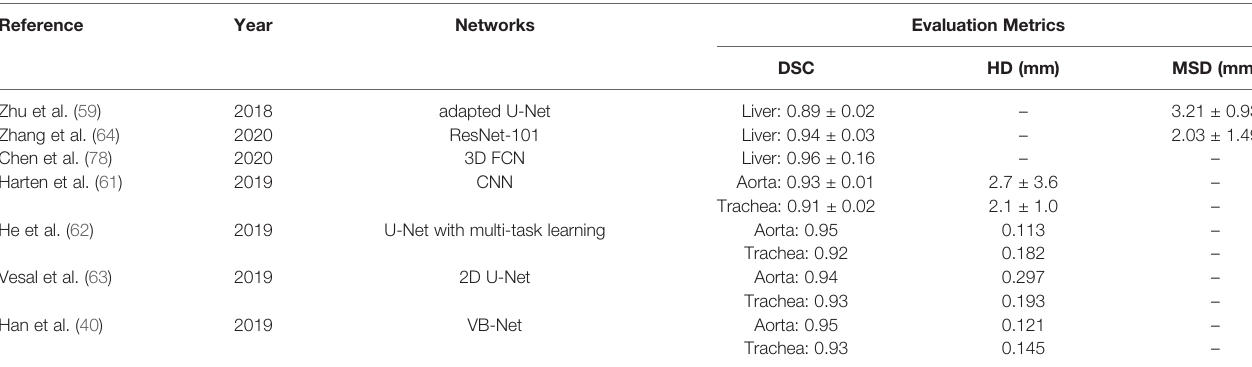
TABLE 6 | Selected works on segmentation of other OARs (liver, aorta,